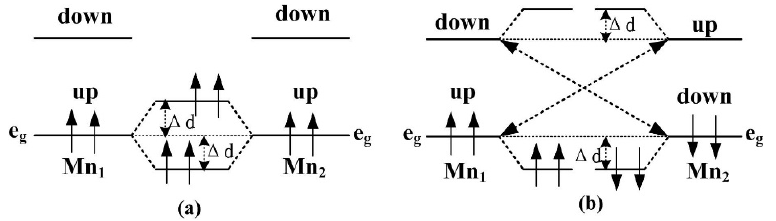
Figure 4. The ferromagnetic (FM) and antiferromagnetic (AFM) mechanisms of the Mn-doped ZnO NW. ( a ) FM coupling; ( b ) AFM